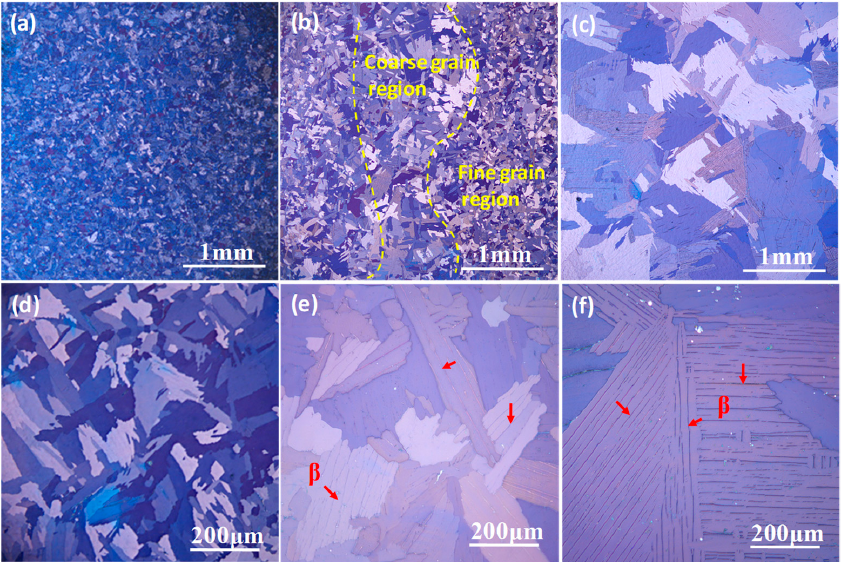
Figure 1. The initial polarized optical microstructures of TA3 alloy with different grain size characteristics. ( a , d ) are FG Ti, ( b , e ) are MG Ti, ( c , f ) are CG Ti. TEM technologies were carried out to identify the acicular phase in the matrix of Figure 1f. Figure 2a,c show the light field image and dark field image of the acicular phase with a thickness of 80 nm in the CG Ti sample. According to the diffraction pattern in Figure 2b, the interface between the α matrix and the acicular phase obeys a classical Burg- ers orientation relationship (cid:4670)0001(cid:4671) (cid:2961) //(cid:4670)011(cid:4671) (cid:2962) and (cid:4666)1(cid:3364)1(cid:3364)20(cid:4667) (cid:2961) //(cid:4666)11(cid:3364)1(cid:4667) (cid:2962) [26,27]. Thus, the acicular phases in Figure 1e,f can be identified as the retained β phase.